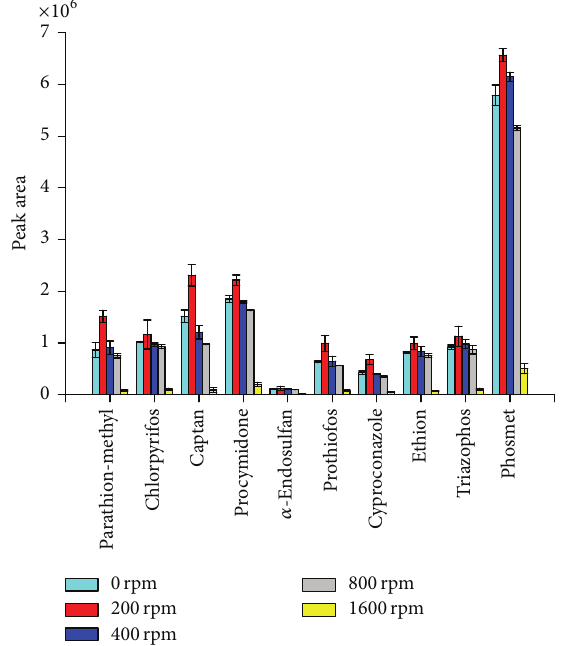
Figure 2: Effect of the stirring speeds on pesticide extraction efficiency. Extraction conditions of the donor phase: 15.0 mL of water spiked at 100.0 𝜇 gL −1 of each pesticide; extraction time of 60 min; and ethyl octanoate in the acceptor phase. Error bars represented the standard deviation of the mean peak area for 𝑛 = 3